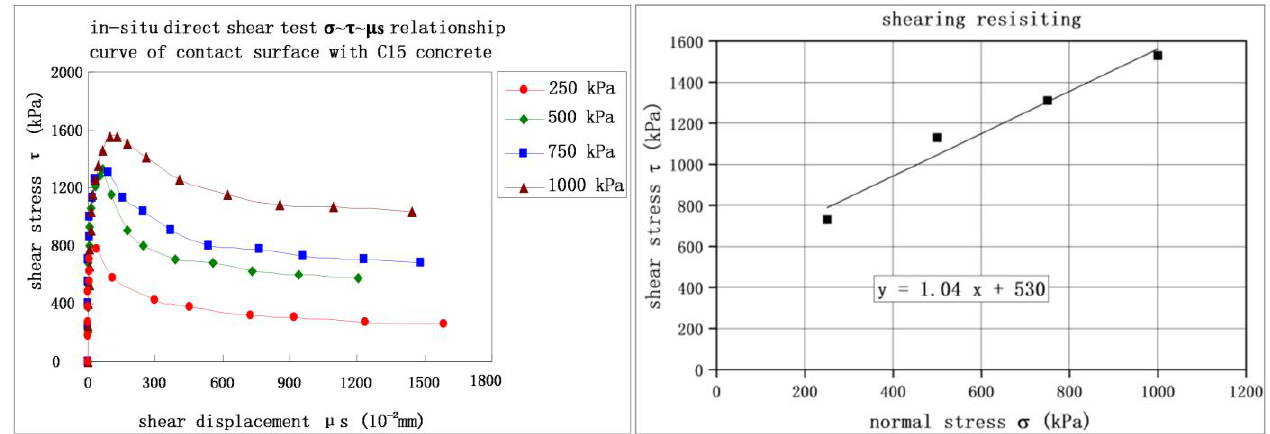
Figure 2. Shear stress–displacement curves of typical measurement points.